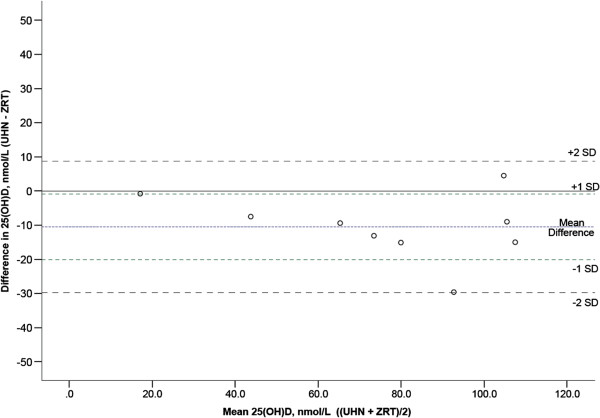
Bland-Altman plot comparing 25(OH)D estimates obtained from serum and blood spots in the same samples.